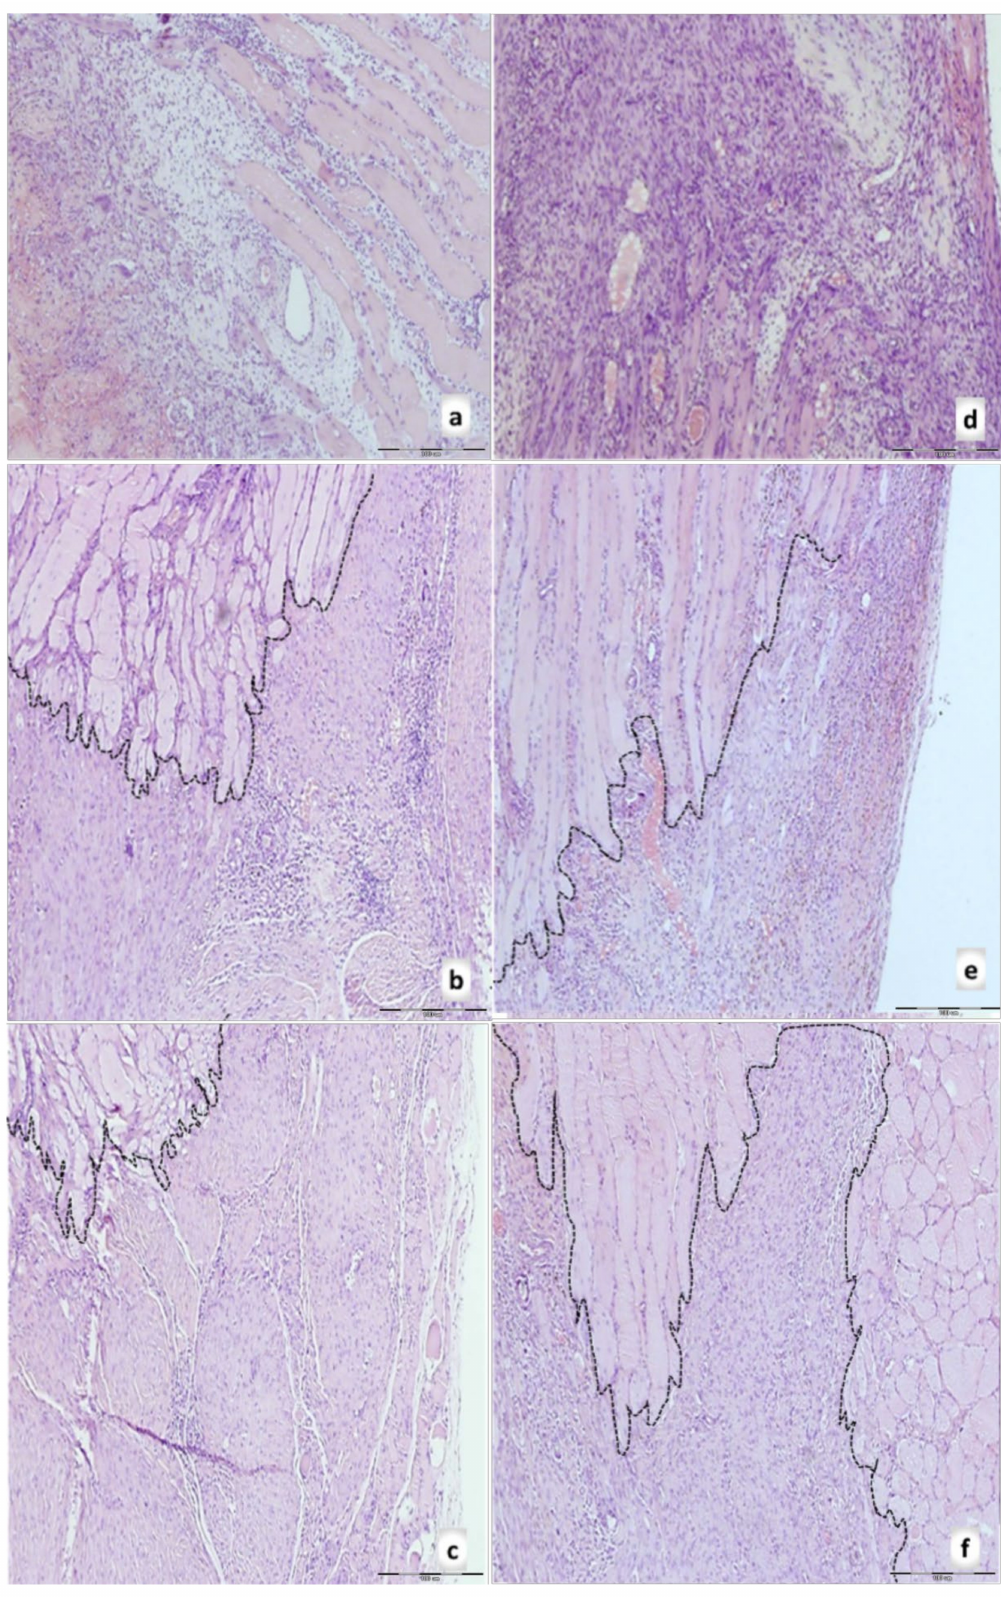
Figure 12. Rats with the disabled myotendinous junction, microscopic presentation of the muscle-tendon junction in control ( a – c ) and BPC 157 ( d – f ) rats at day 7 (upper), day 14 (middle), and day 28 (lower) of the myotendinous junction injury. Dashed border of the muscle cell endings (HE staining; magnification × 100). Control group: prominent edema,